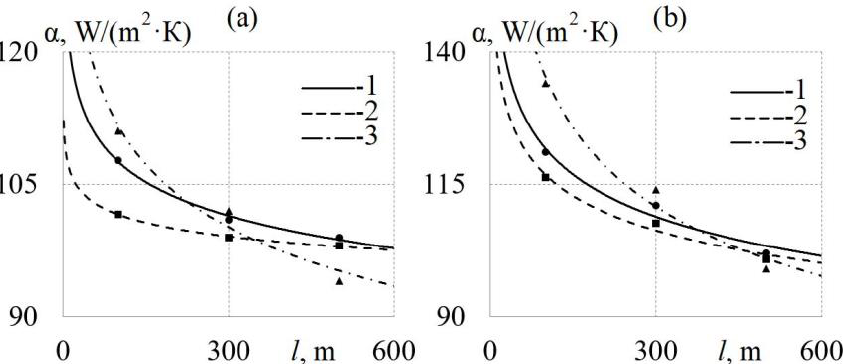
Figure 10. Dependences of the local heat transfer coefficient α along the length of round (1), square (2), and triangular (3) pipes for average air velocity w = 20 m/s and at initial values TI: ( а ) TI = 0.02; ( b ) TI = 0.12.